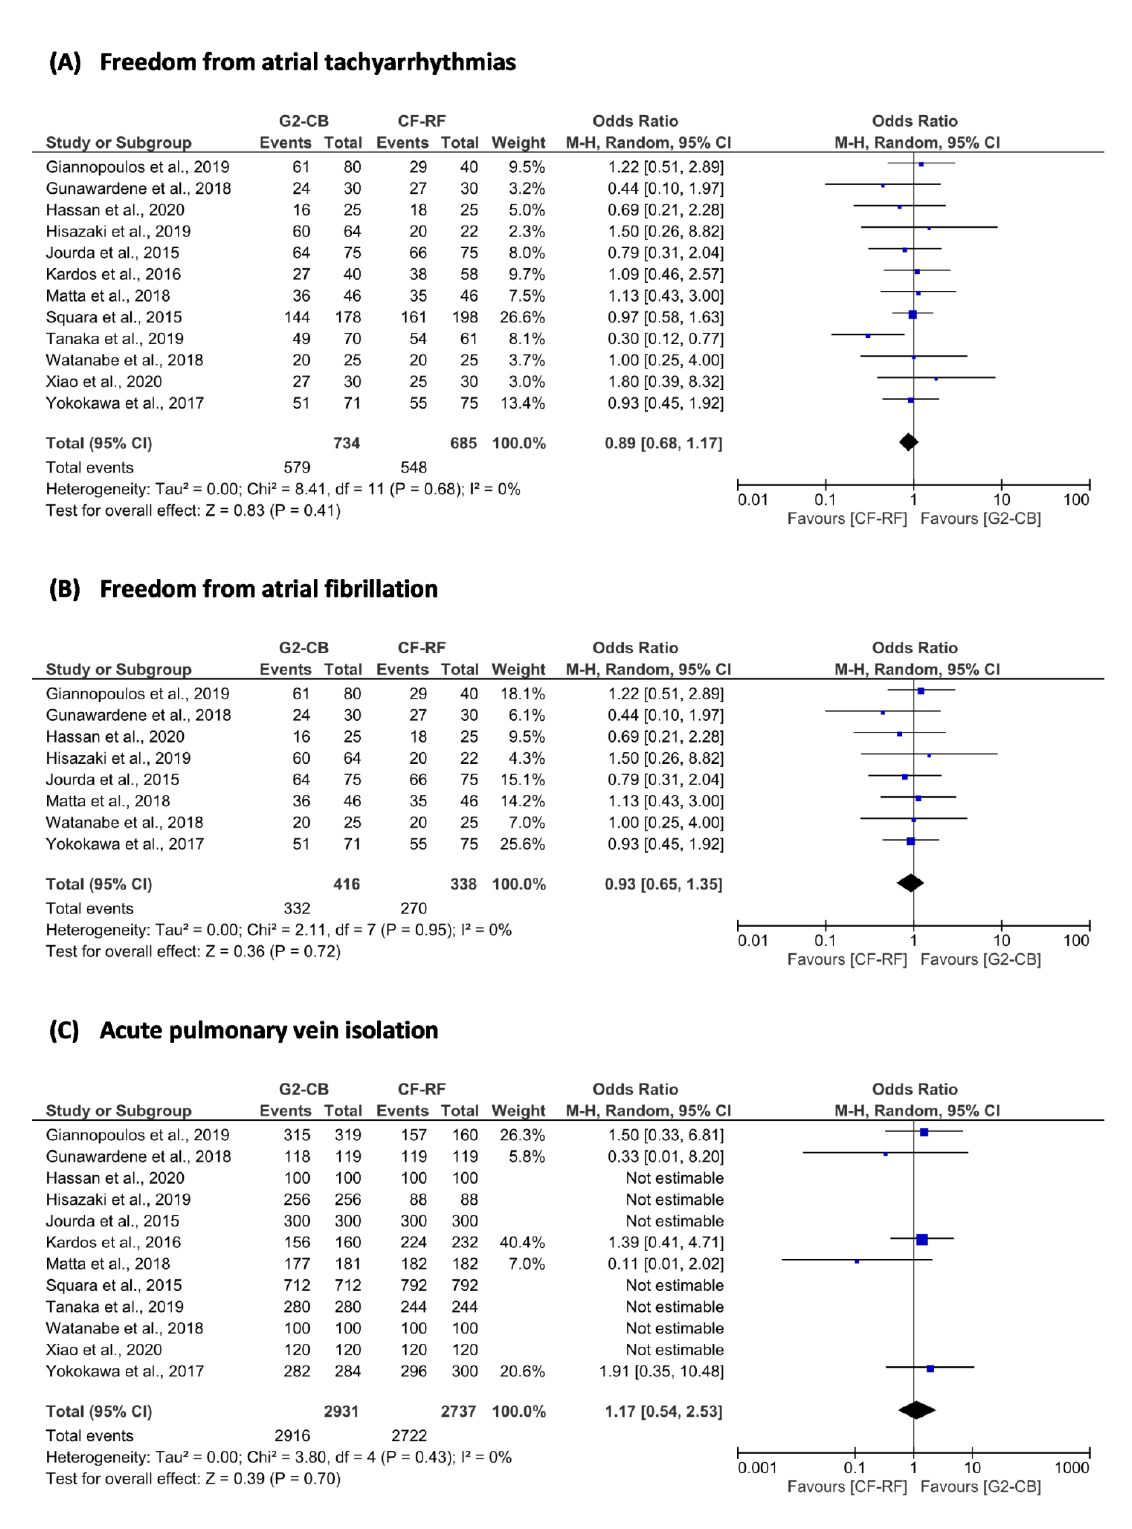
Figure 2. Forest plot of ( A ) freedom from atrial tachyarrhythmias; ( B ) freedom from atrial fibrillation; and ( C ) acute pulmonary vein isolation. 2G-CB = second-generation cryoballoon; CF-RF = contact force-sensing radiofrequency; CI =confidence interval; M – H = Mantel – Haenszel.